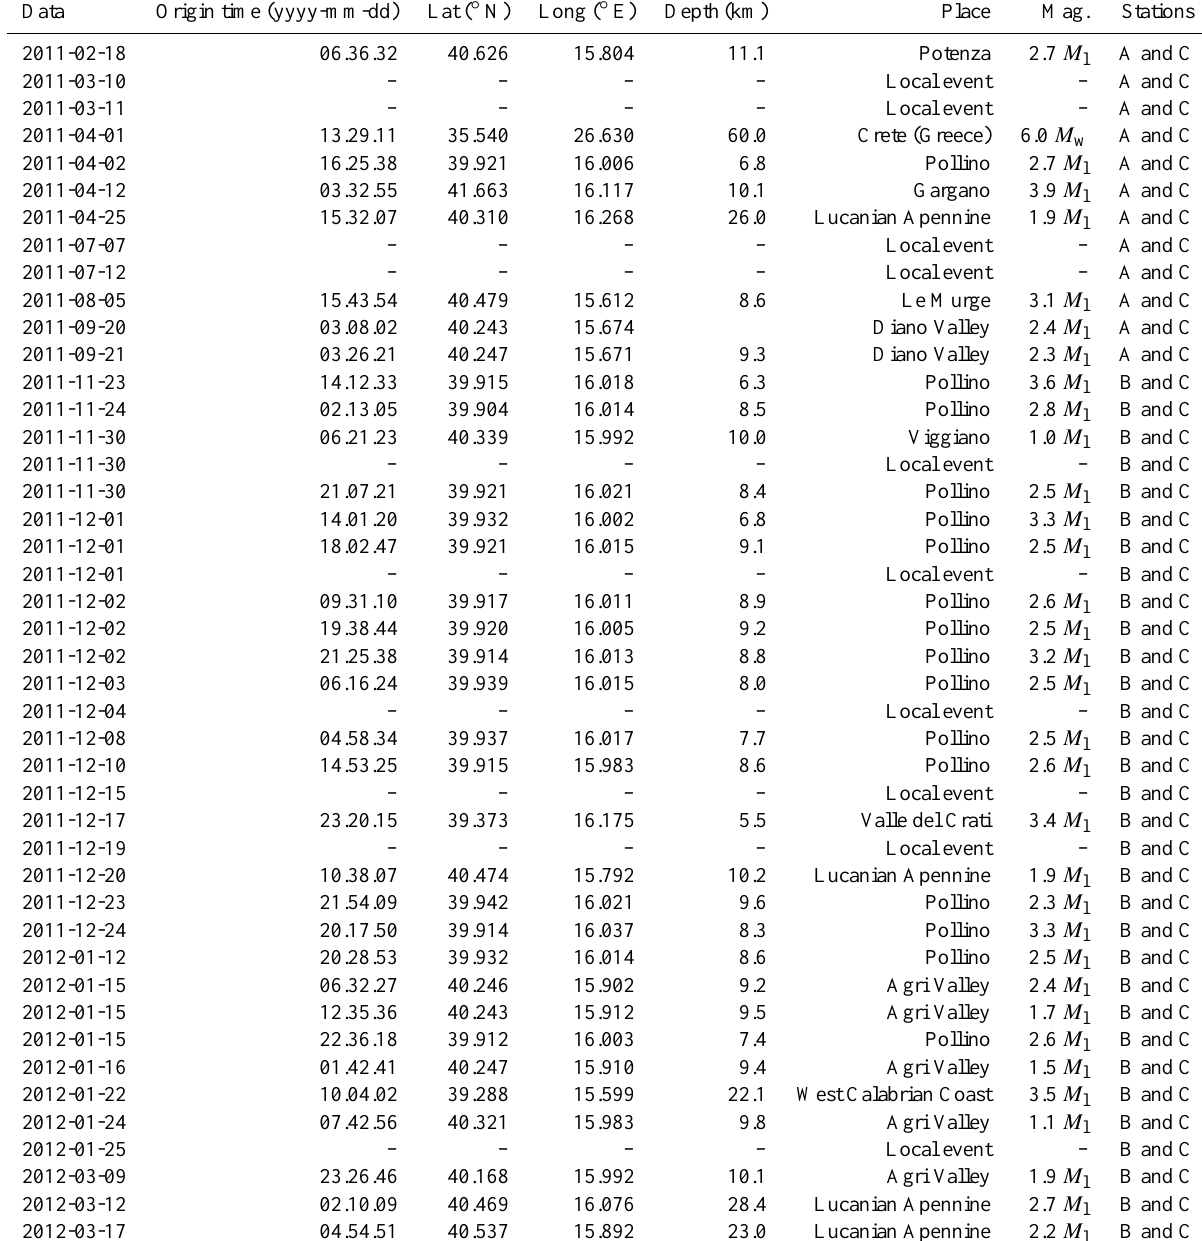
Table 1. List of earthquakes recorded from February 2011 to March 2012 by the accelerometric stations A, B, and C installed in Montemurro.